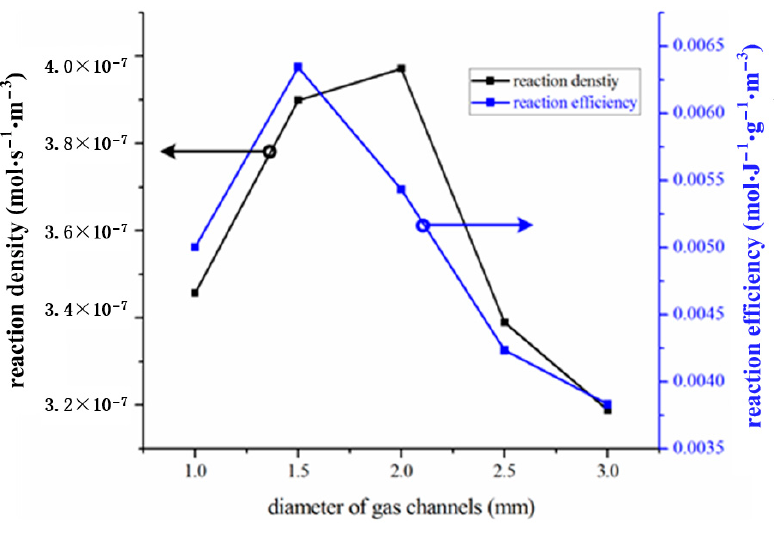
Figure 11. The variation of reaction density and efficiency with a diameter of gas channels.